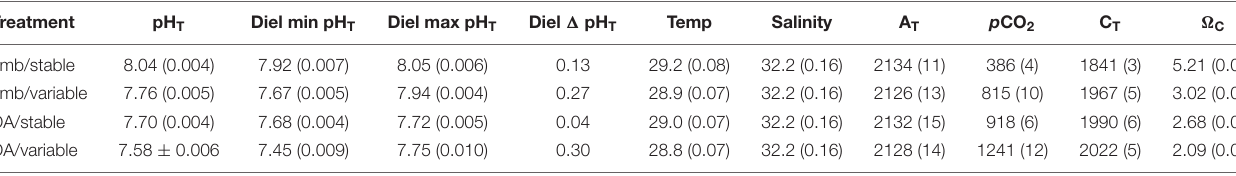
TABLE 1 | Mean ( ± SE) physical conditions of treatments calculated from daily discrete measurements and weekly water samples. Treatment